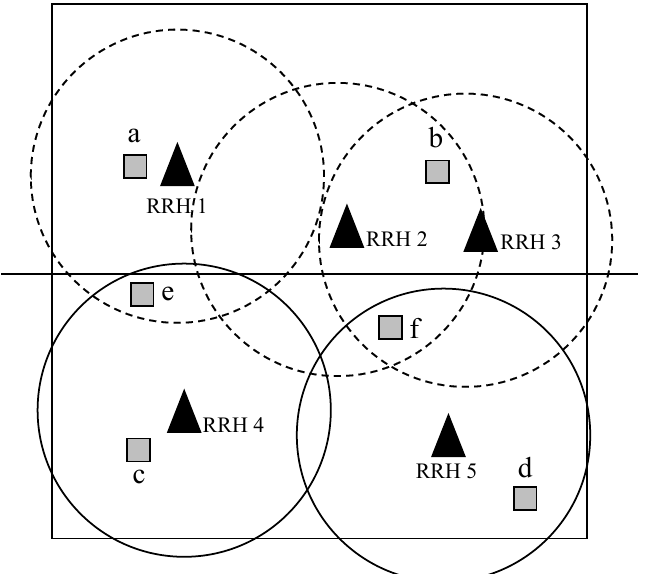
Figure 11. An example network with five RRHs from 1 to 5 and six IoT devices from a to f . The network is divided into two sectors, i.e., the upper and lower sectors, where RRHs 1–3 and 4–5 belong to the upper and lower sector,